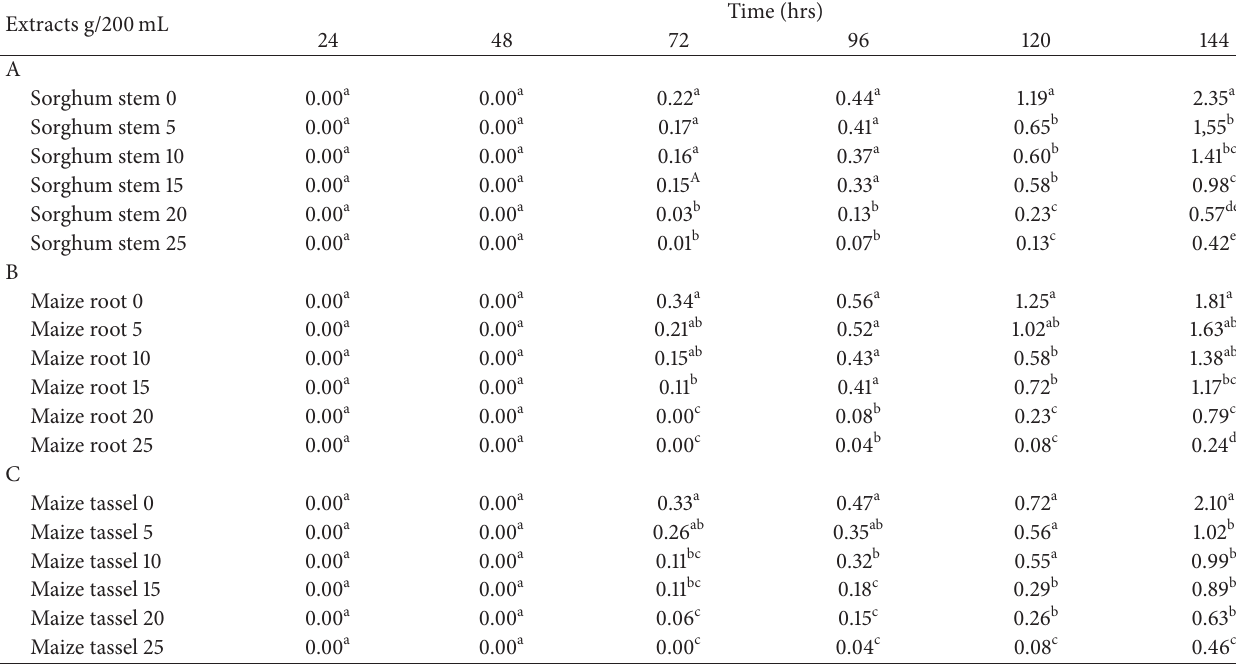
Table 3: Effects of aqueous extracts of sorghum stem and maize (roots and tassel) on the plumule length (cm) of okra. Extracts g/200